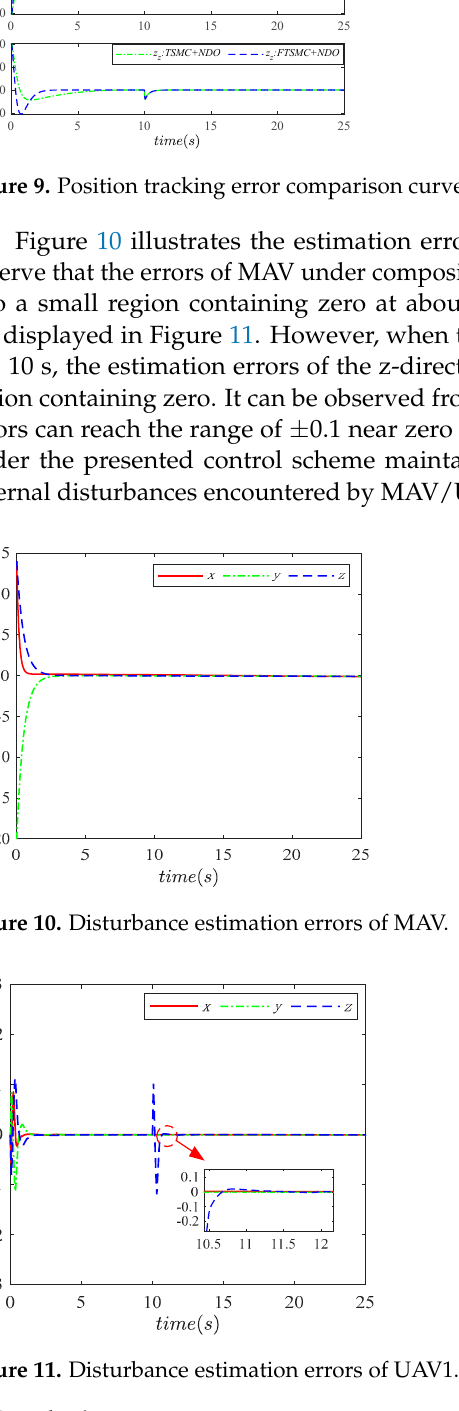
Figure 11. Disturbance estimation errors of UAV1.